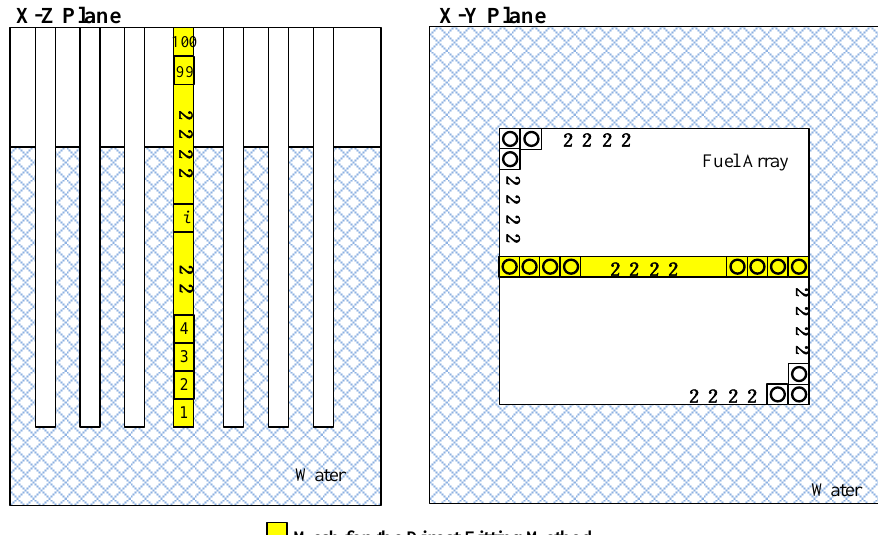
Figure 3. Meshes for vertical extrapolation length calculation.